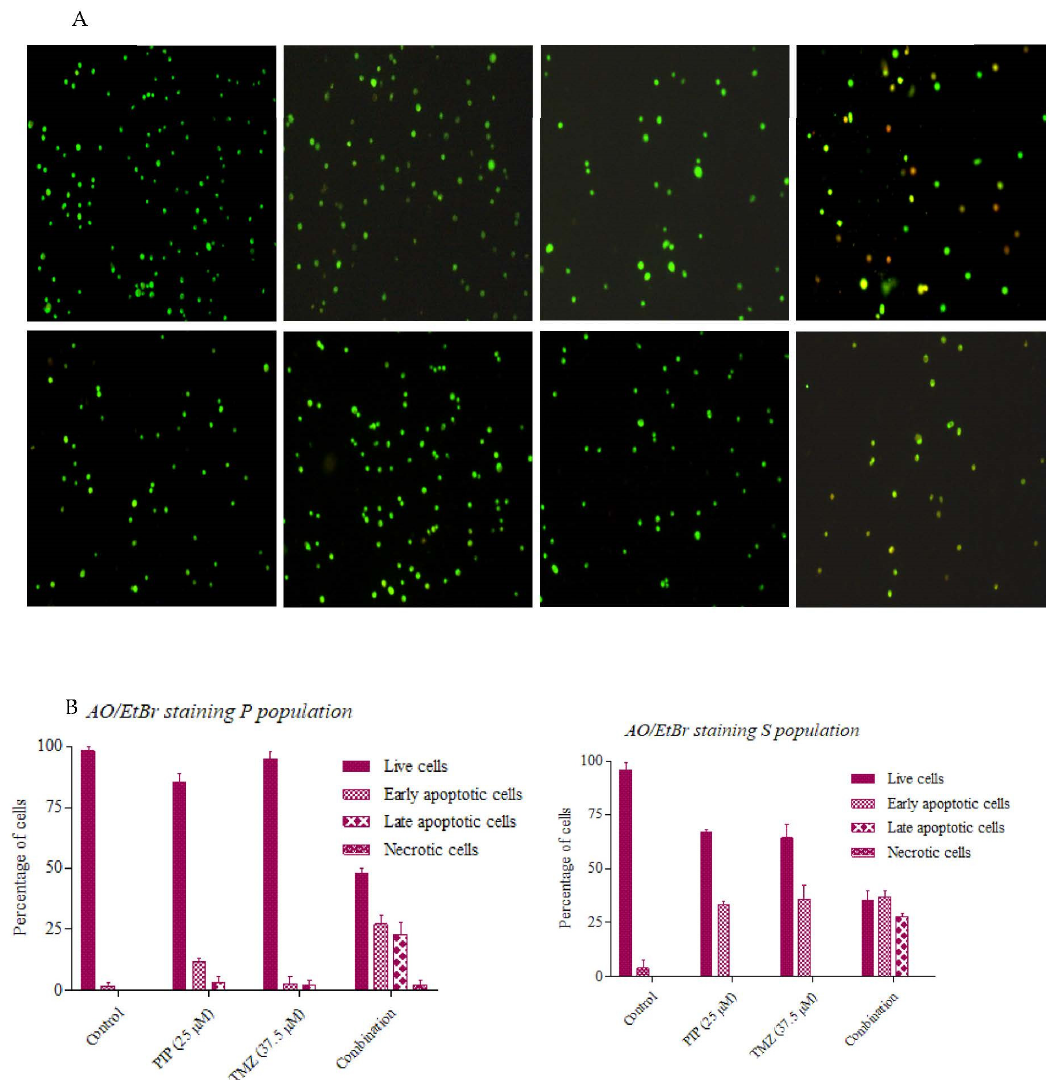
Figure 15. Effect of PIP and TMZ on apoptosis. ( A ) Fluorescent images of AO/EtBr staining of both P and S populations with and without treatment. ( B ) Quantitative analysis of the percentage of average number of live, early apoptotic, late apoptotic and necrotic cells in P and S populations with and without treatment.